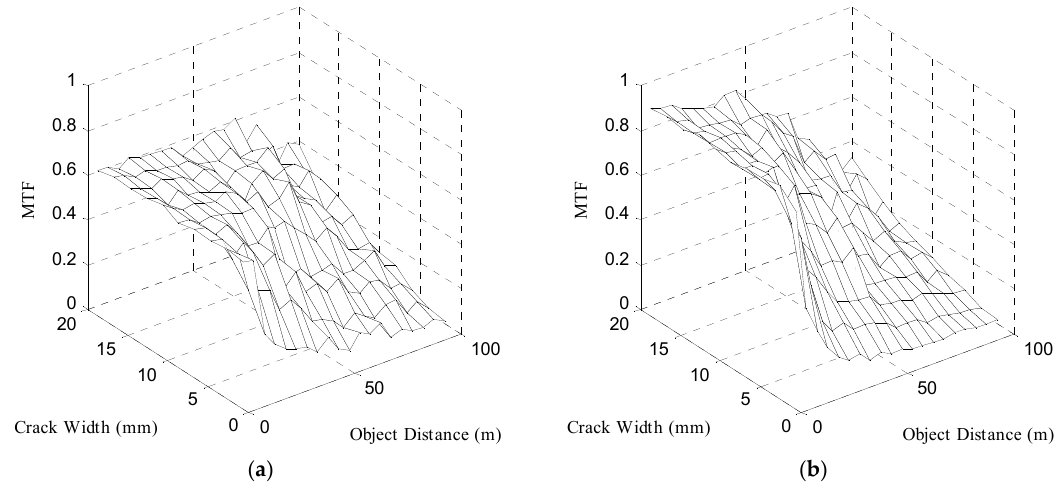
Figure 13. Two-dimensional representation of MTF acquired at the boundary line of the crack image using the sine wave method with the illumination: ( a ) 13 lx, ( b ) 52,000 lx.